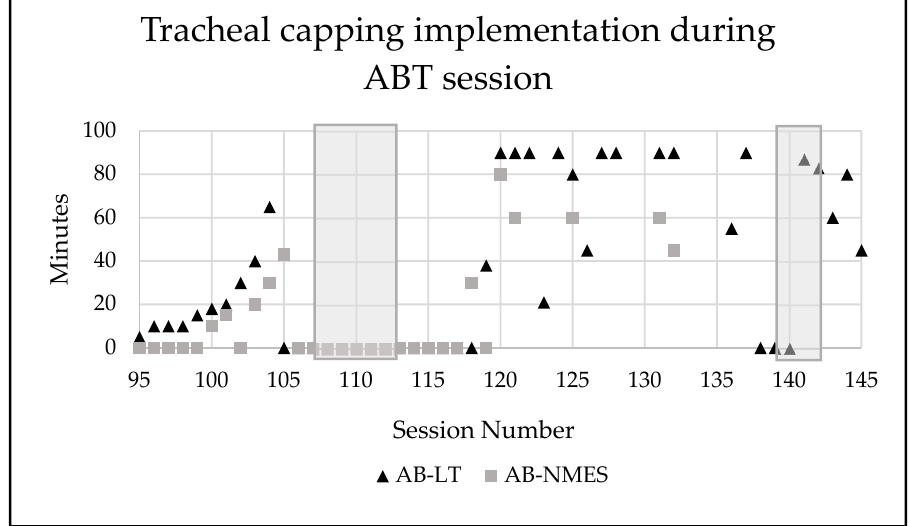
Figure 6. Number of minutes the patient’s tracheostomy was capped during activity-based therapy sessions. Grey shadow indicates a time period where patient was sick (cold, viral infection). AB-LT = activity-based locomotor training. AB-NMES = activity-based neuromuscular electrical stimulation. Table 1. Sleep study results. TST = total sleep time, AHI = apnea-hypopnea index, REM = rapid eye movement, OAI = obstructive apnea index, OHI = obstructive hypopnea index, CAI = central apnea index, h = hour, SpO 2 = peripheral oxygen saturation .